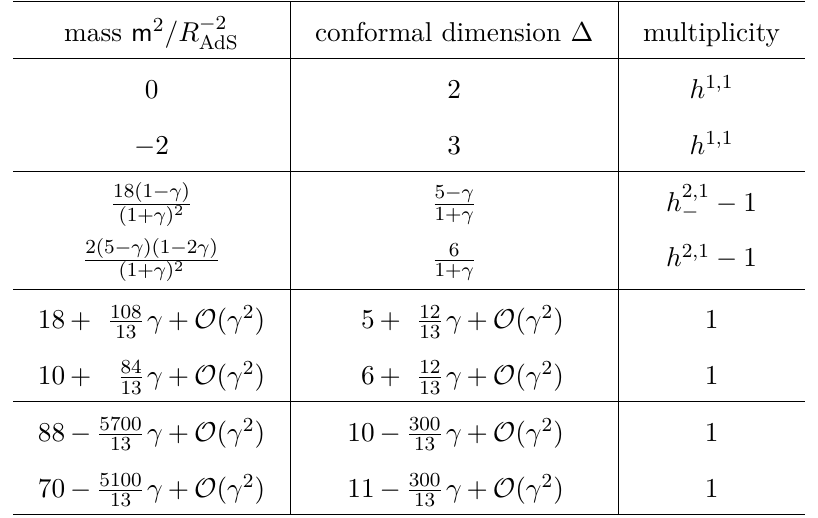
Table 1 . Eigenvectors and eigenvalues of the matrix QQ shown in (4.7). The vectors L A and L i satisfy K L A = 0 and K L i = 0 , and the parameters η i A and η = − 4 + 48 γ + O ( γ 2 ) . The precise expressions for the eigenvalues and eigenvectors in the (2) 13 last two lines are shown in appendix A.2.